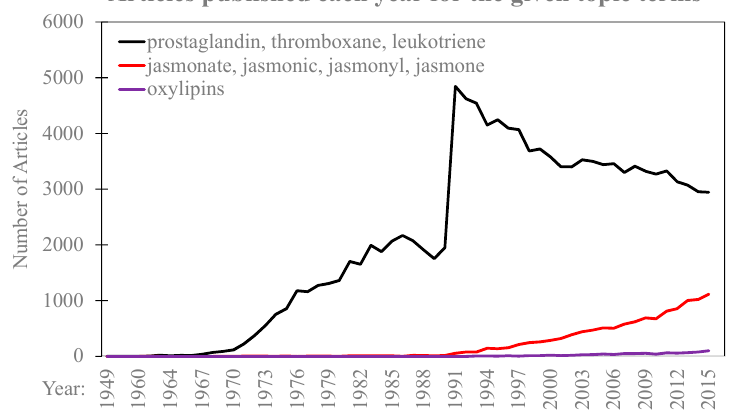
Figure 1. Articles published each year for the given topic terms related to mammalian and plant oxylipins. The x-axis represents year from 1949 to 2015 and y-axis represents the number of articles published each year for the selected topic terms. The line representing the terms related to mammalian oxylipins (terms “prostaglandin”, “thromboxane”, and “leukotriene”), known as eicosanoids, and is colored black. The line representing jasmonates (terms “jasmonate”, “jasmonic”, “jasmonyl”, and “jasmone”) is colored red. Plant oxylipins (term “oxylipins”) is colored purple. Terms were searched in the Web of Science TM citation indexing service and organized per year.